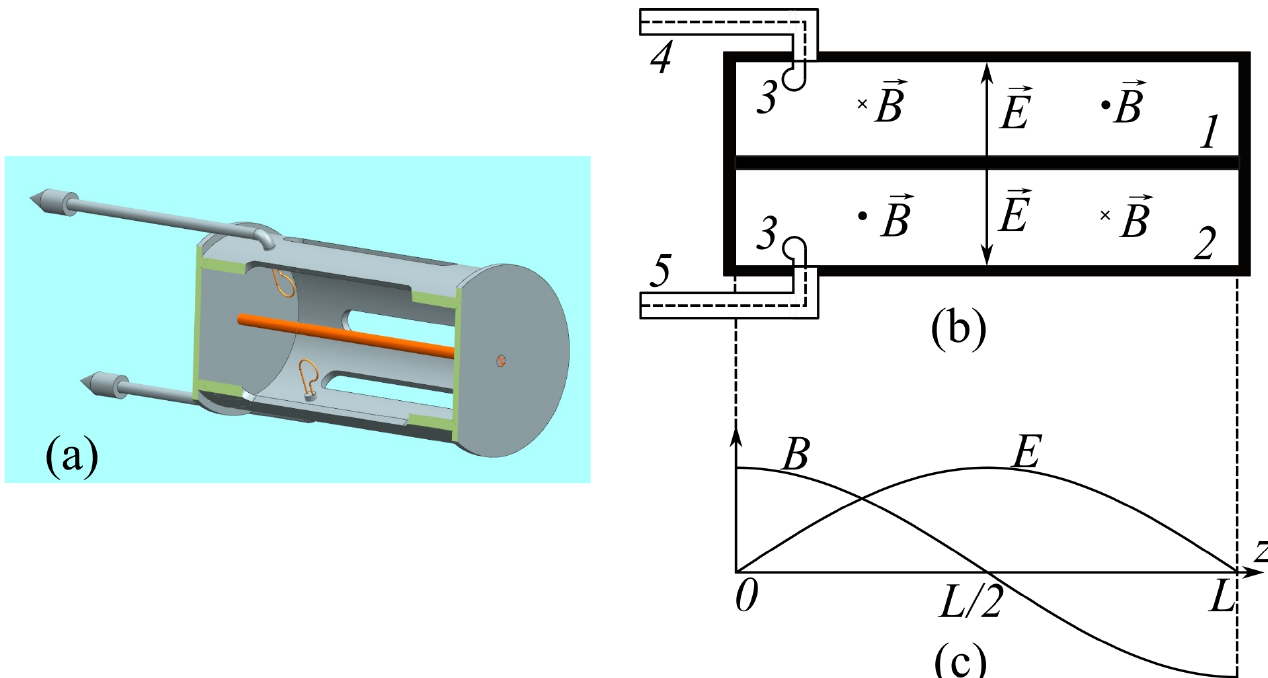
Figure 1. Humidity sensor. ( a ) Sectional view of the 3D model; ( b ) cavity diagram: internal conductor (1), external conductor (2), magnetic coupling loops (3), cavity excitation line (4), and receiving line (5); and ( c ) distribution of electric E and magnetic B fields along the axis z of the cylinder.